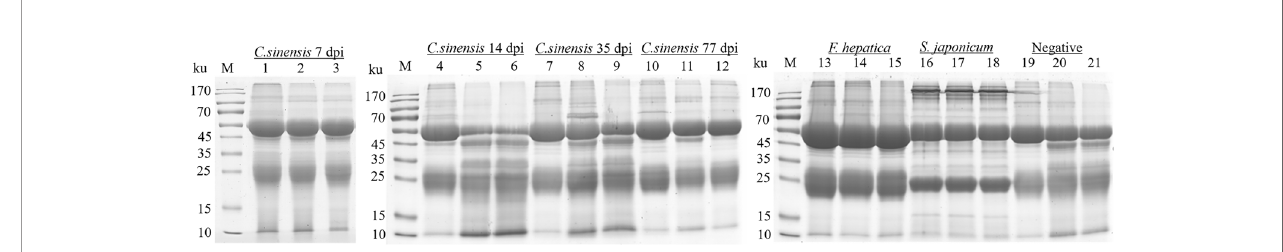
FIGURE 2 | SDS-PAGE analysis of rabbit sera samples of C. sinensis at different infection period; F. hepatica and S. japonicum were co-cultured with the C. sinensis ESPs. Lines 1-3: proteins pulled down by rabbit serum at 7 dpi with C. sinensis . Lines 4-6: proteins pulled down by rabbit serum at 14 dpi with C. sinensis . Lines 7-9: proteins pulled down by rabbit serum at 35 dpi with C. sinensis . Lines 10-12: proteins pulled down by rabbit serum at 77 dpi with C. sinensis . Lines 13-15: proteins pulled down by F. hepatica serum. Lines 16-18: proteins pulled down by S. japonicum serum. Lines 19-21: proteins pulled down by rabbit negative serum.